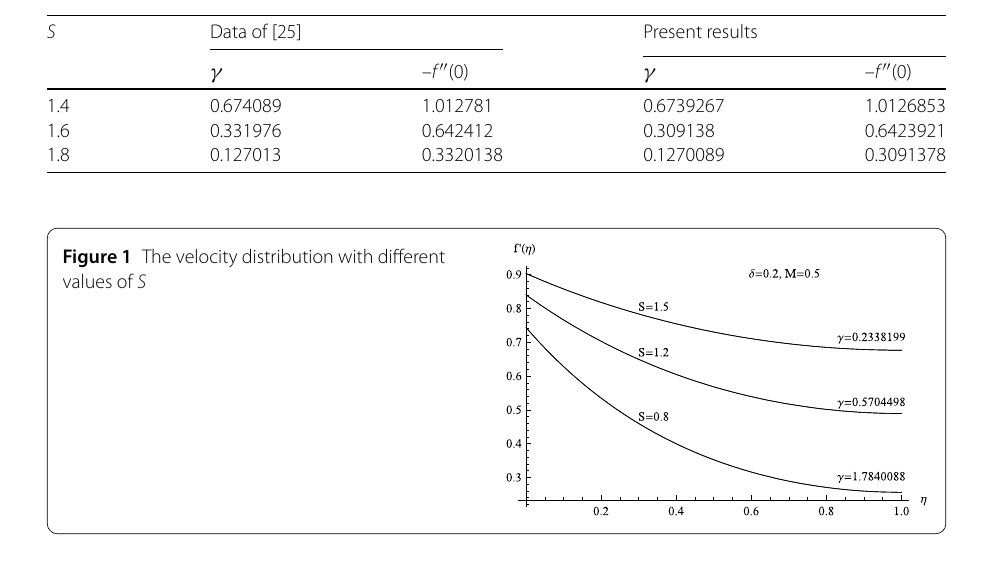
Table 1 Comparison of γ and – f (cid:2)(cid:2) (0) with δ = M = 0 using the previous work and the Chebyshev collocation method